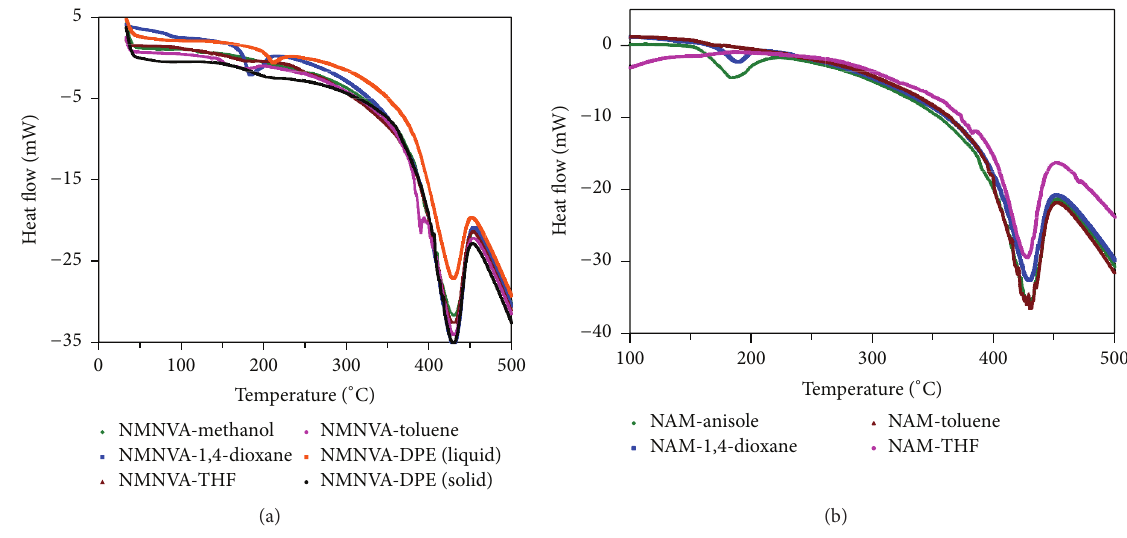
Figure 6: DSC curves of poly(NMNVA) (a) and poly(NAM) (b) [2nd heating run, heating rate 5 ∘ C/min; N 2 flow; 30 mL/min].